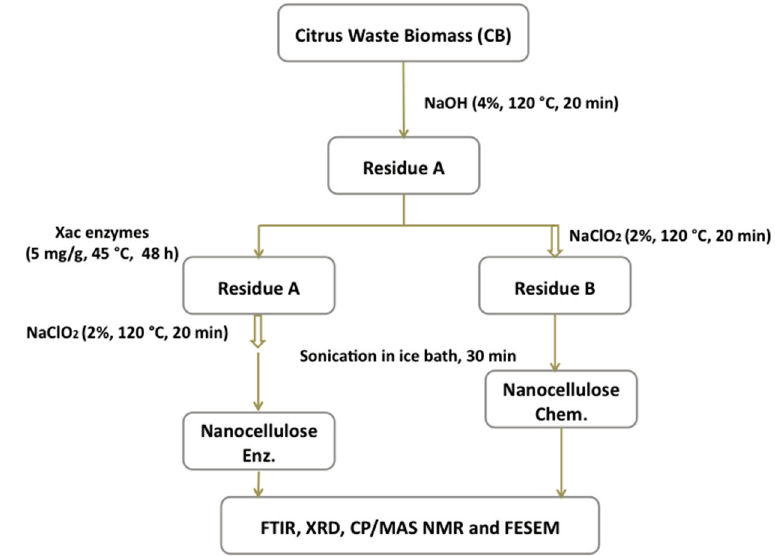
Figure 6 . Flowchart illustrating the key steps in the Citrus-waste Biomass (CB) processing used to produce nanocellulose